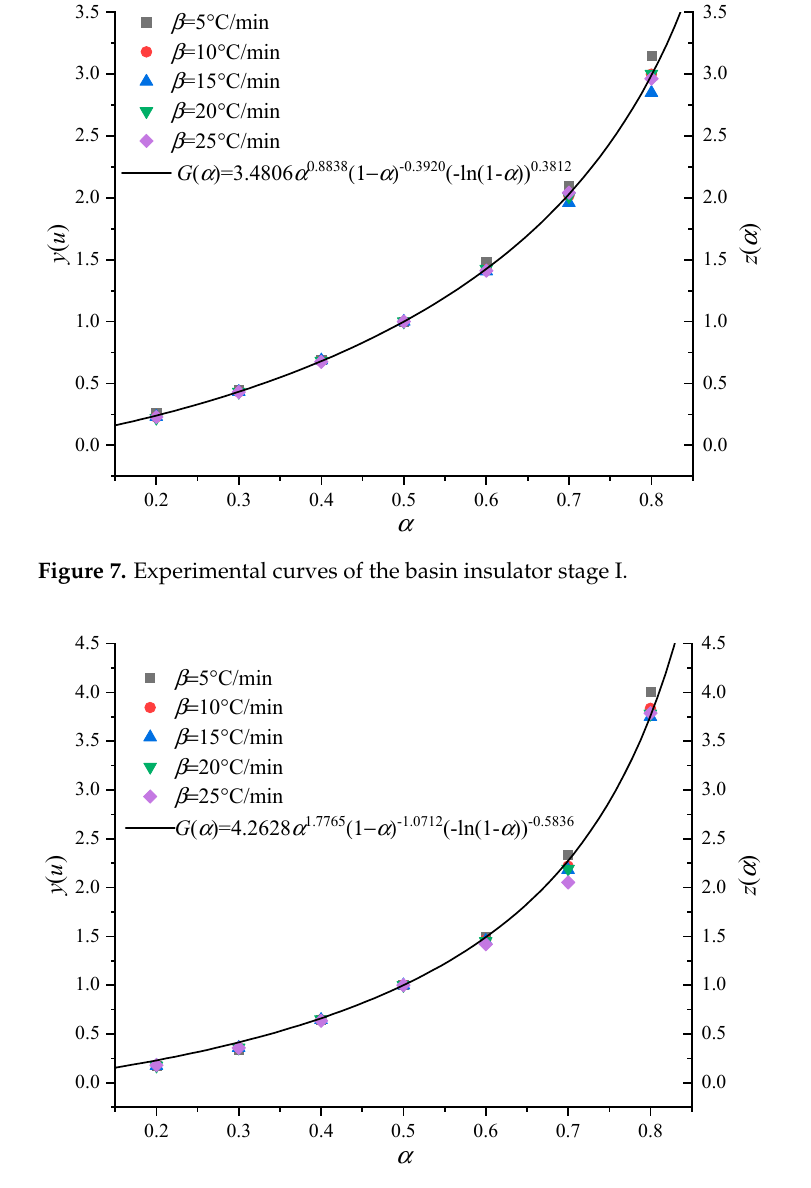
Figure 8. Experimental curves of the basin insulator stage II.